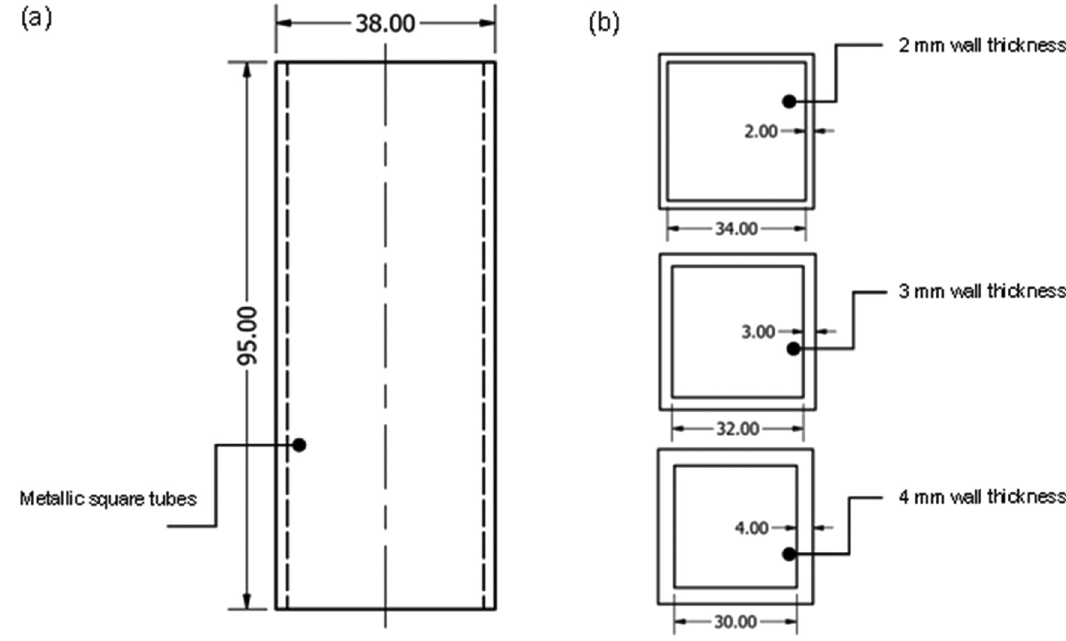
Figure 8: ( a ) Dimension of the tube. ( b ) Dimension of the wall